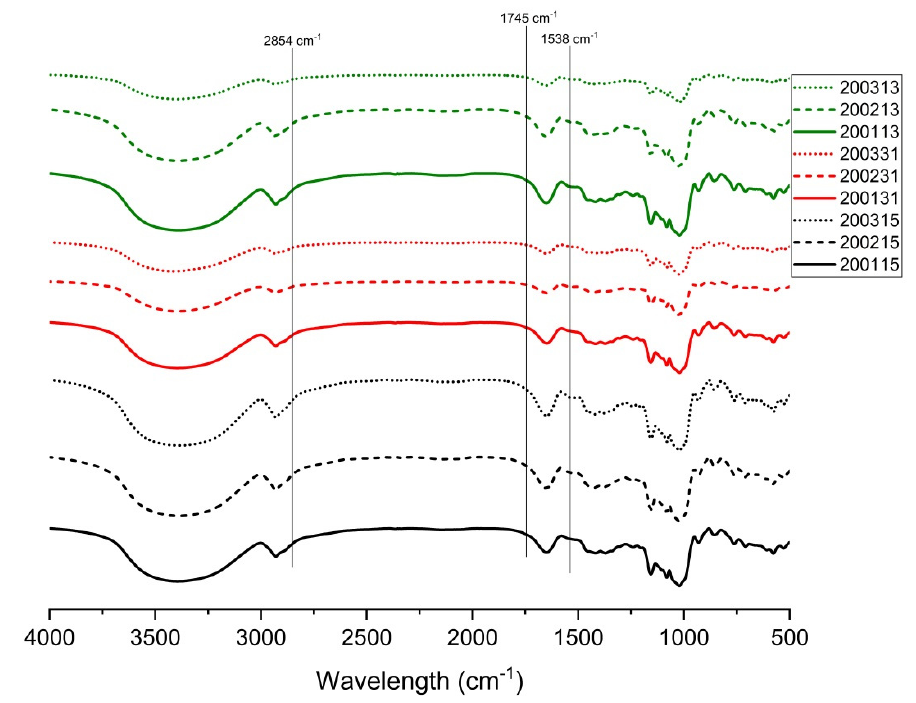
Figure 4. FTIR transmittance spectra of starch in recombinant flours.